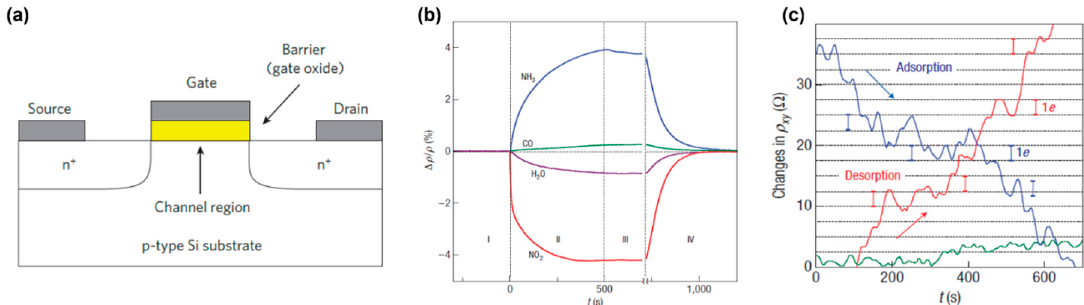
Figure 4. ( a ) The cross-section of a FET. ( b ) Relative change in resistivity of single layer graphene (SLG) at zero magnetic fields exposed to different diluted gas molecules with a concentration of 1ppm. The positive signals indicate electron doping while the negative ones indicate hole doping. Region I: Resistivity change of SLG in a vacuum; II: SLG exposed to diluted gas molecules; III: Expulsion of gas molecules; IV: SLG annealed. ( c ) Change in the Hall resistivity ( ρ xy ) of SLG due to adsorption (blue curve) and desorption (red curve) of a single NO 2 molecule (adsorption). The green curve shows the response of SLG to pure He. Preprinted with permission from Reference [16,89].